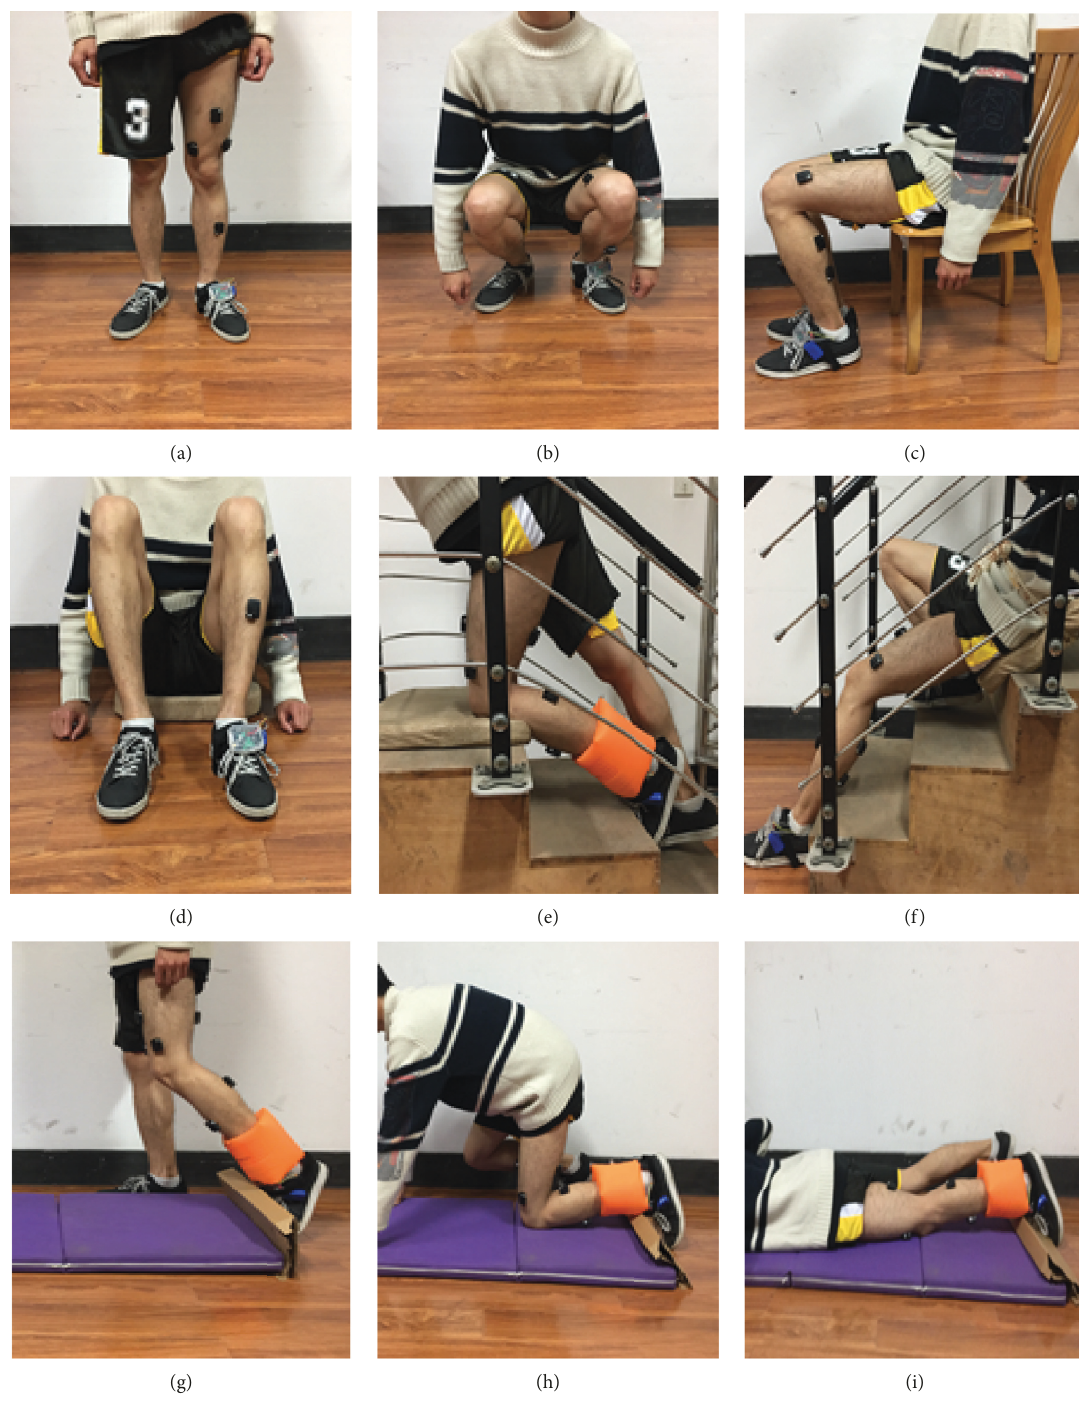
Figure 1: Partial experimental activities: (a) standing, (b) squatting, (c) sitting on a chair, (d) sitting on the ground, (e) going upstairs-falling, (f) going downstairs-falling, and (g)–(i)